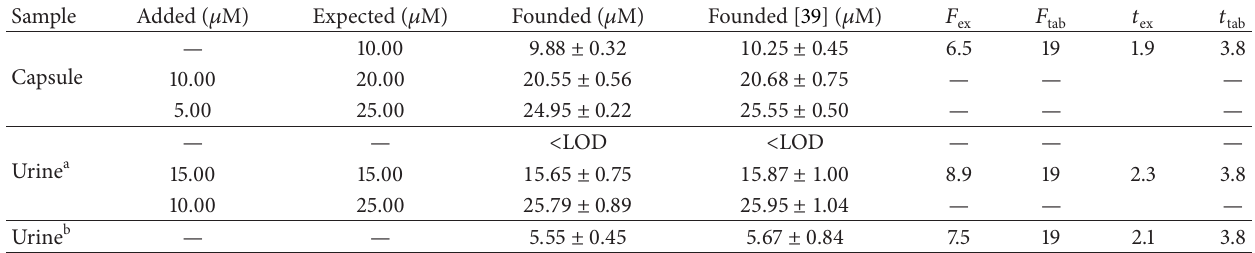
Table 2: Determination of cysteamine in real samples ( 𝑛 = 3